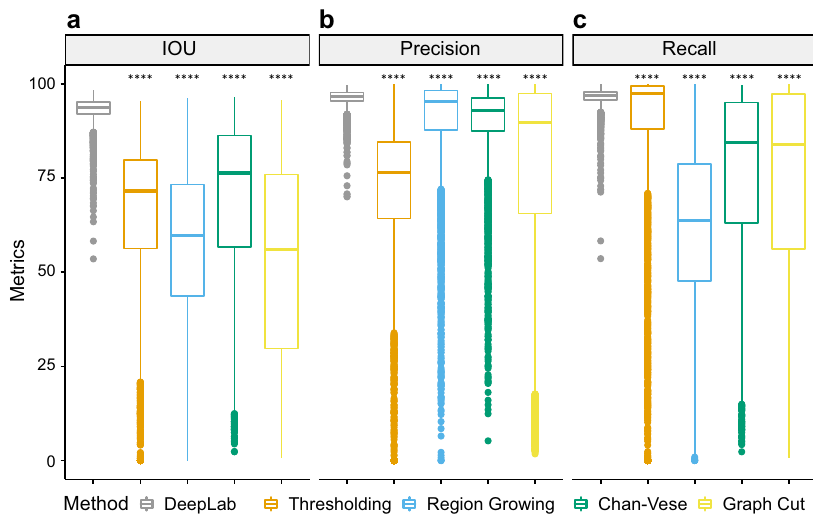
Fig.1|Theperformanceofpredictions( N =5094)fromDeepLabv3+andclassic methods. Thetestedclassicmethodsarethresholding,regiongrowing,Chan-Vese and graph cut. a IOU, b Precision, and c Recall are used to evaluate the perfor- mance. Asterisks indicate evidence for comparing the predictions of classic